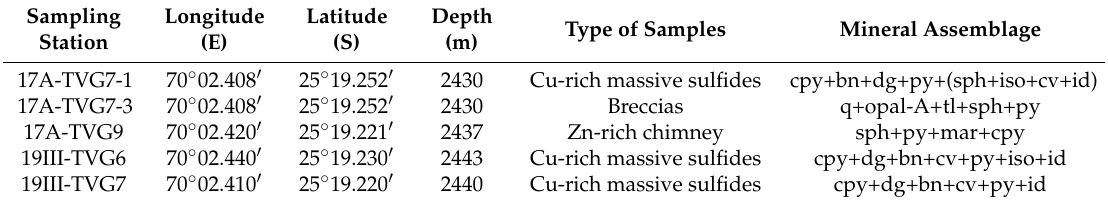
Table 1. Coordinates of sampling stations and mineral abundances of the sulfides from the Kairei vent